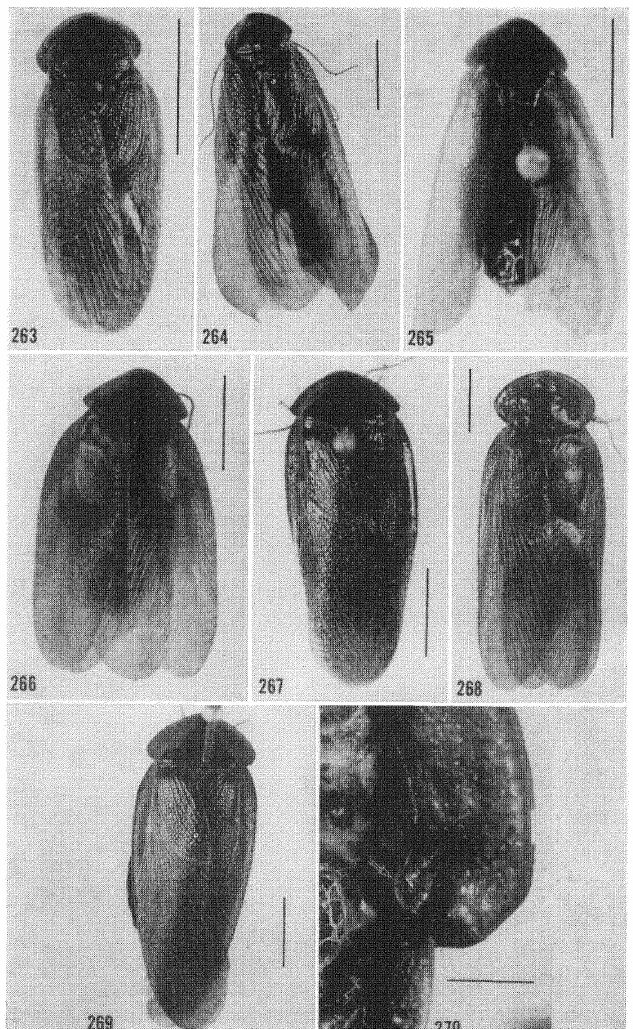
Figures 263-270. Adult males of Trichoblatta spp. 263. (987 L). T. lygmaea (Karny). Ryukyu (det. Prineis). 264. (985 L). T. tarsalis (Walker). Kambaiti, N.E. Burma, 7000’ (det. Prineis). 265. (984 L). T. sericea (Sauss.). Madras, India (det. Prineis). 266. (8 BMNH). T. guerini 8auss. and Zehn. "Givalior" (de.t. Prineis). 267. (988 L). T. oniscina (Gerstaeeker). Urwald, Ukaika (det. Prineis). 268. (986 L). T. magniflca (Shelford). Tonkin, Chapa, Indo-China (det. Prineis). 269-270. (103 MCZ). 269. T. nigra (Shiraki). Formosa (det. Prineis). 270. Tooth (arrow) on underside of pronotum. (scale: Figs. 263-269:---5 mm; Fig. 270